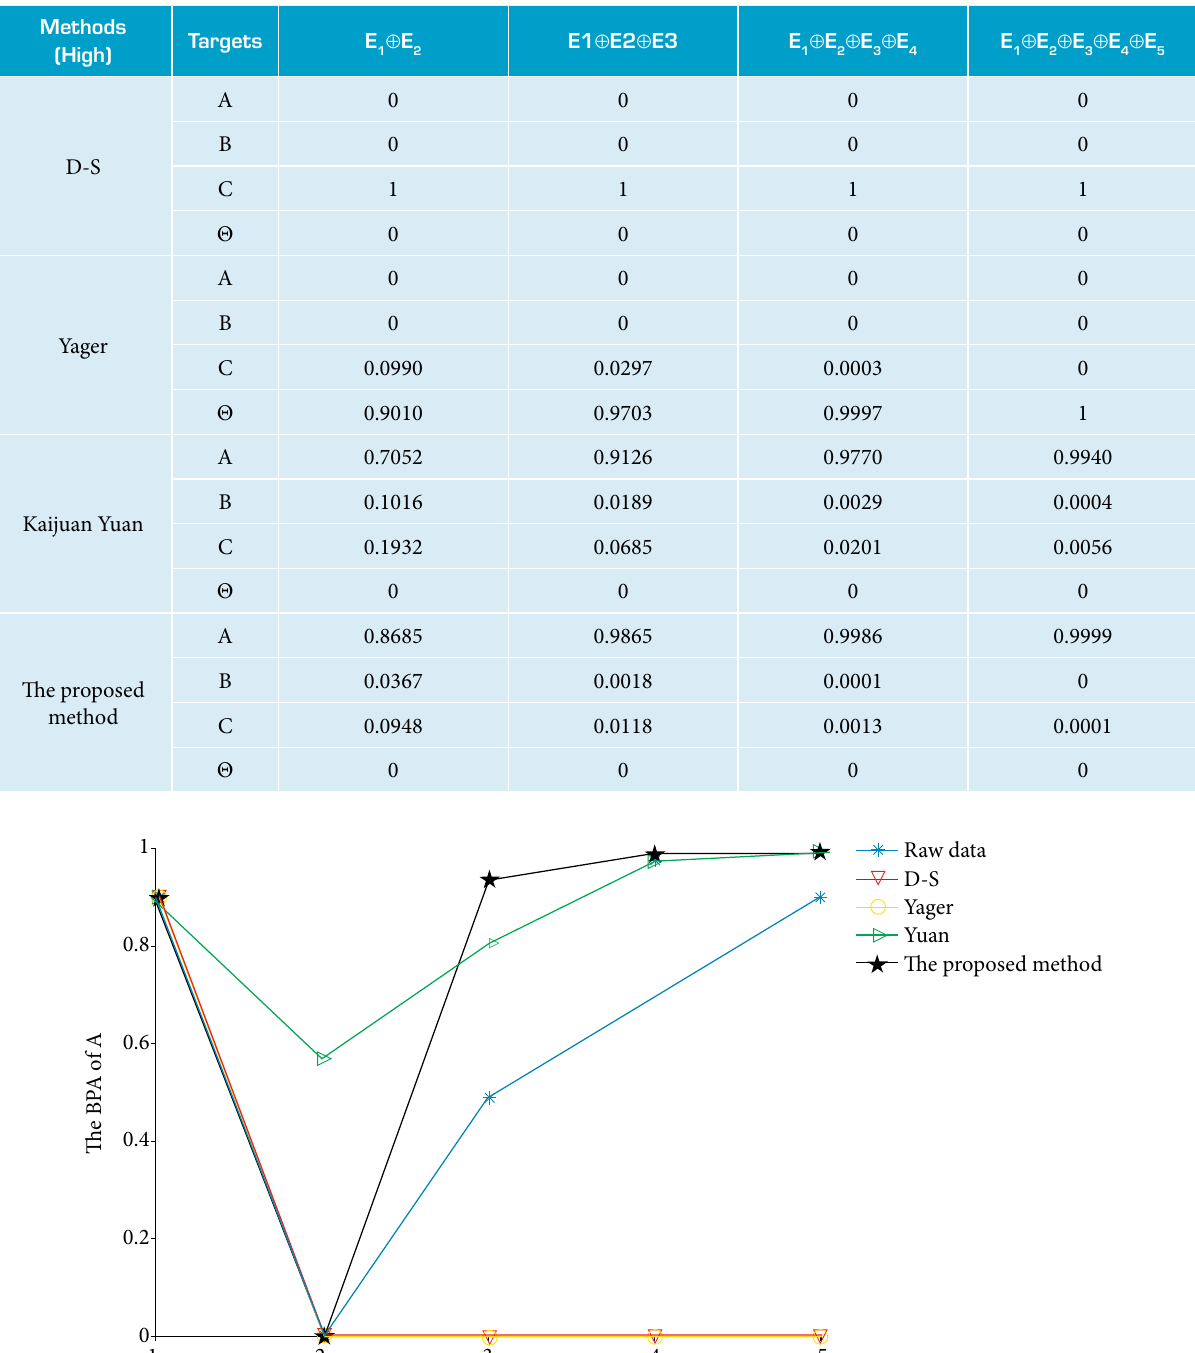
Table 4. Fusion results of different methods with highly conflicting information.